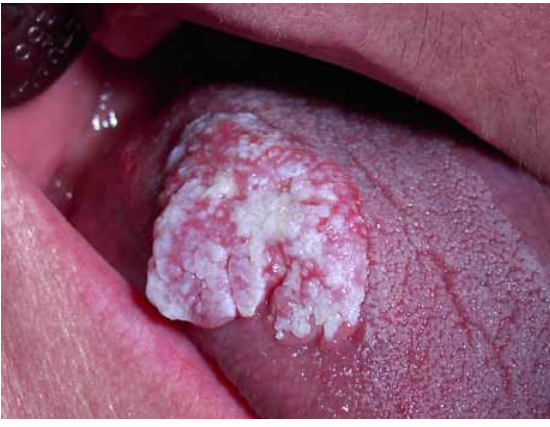
Figure 1. Patient K.S. 62 yrs. Tumour on the dorsal surface of the tongue.